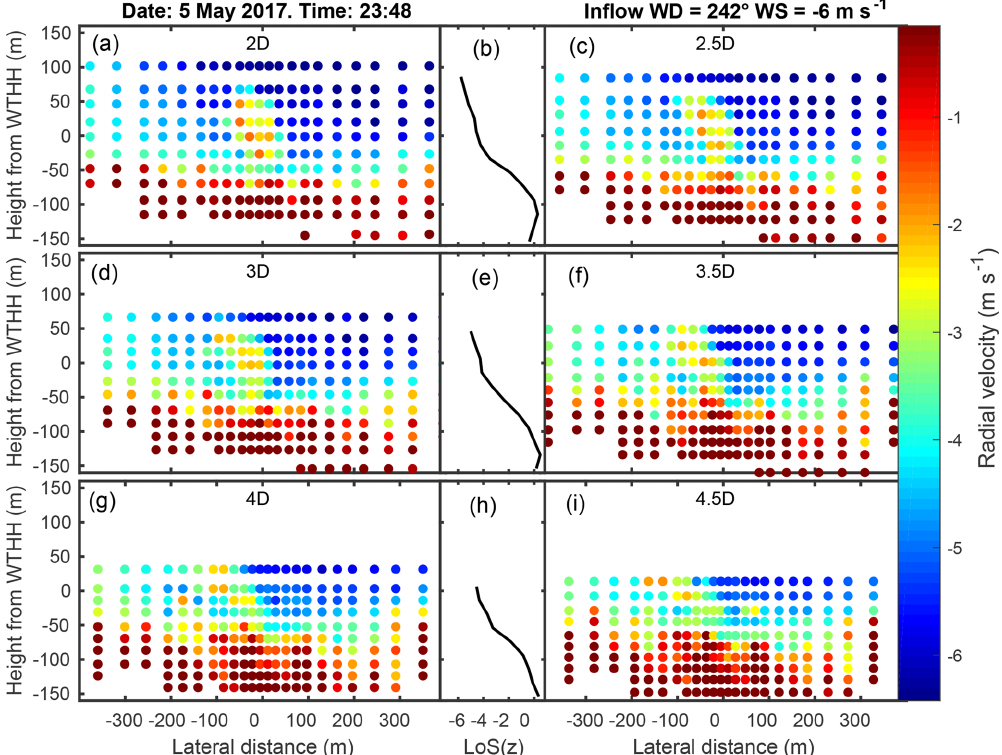
Figure 6. Example of raw radial wind speeds on planes at the six downstream distances, 2, 2.5, 3, 3.5, 4 and 4.5 D , from the arc scans on 5 May 2017 at 23:48 (UTC; shown in Fig. 5). In (b, e, h) , the mean background radial wind speed profile (LoS( z )) is shown at 2.5, 3.5 and 4.5 D . A lateral distance of 0 (on the x axis) indicates a direct line to the wind turbine (i.e. a direction of 227 ◦ ). The heights on the vertical axis have been normalized to be 0 at the